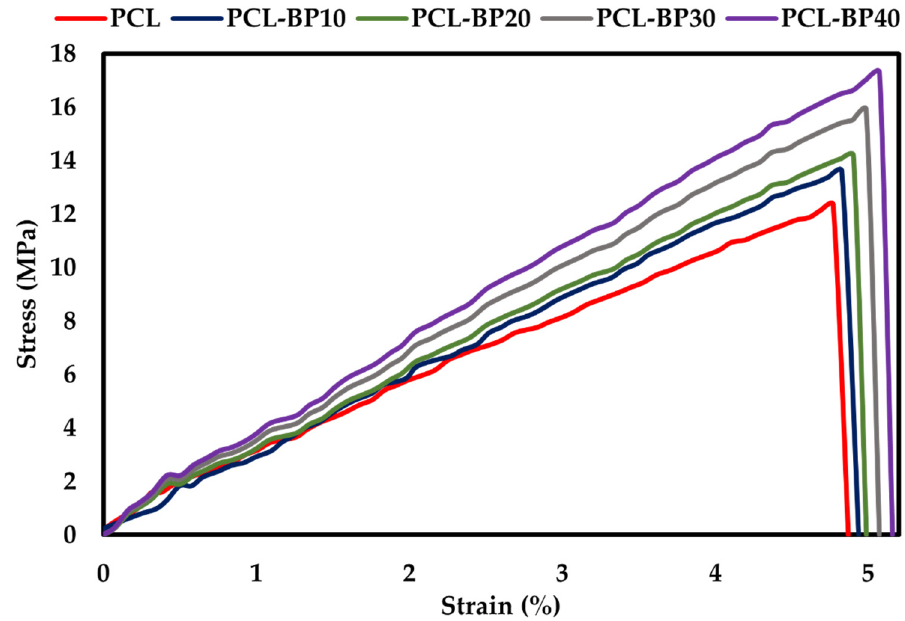
Figure 9. Flexural curves of PCL and PCL-BP composites.